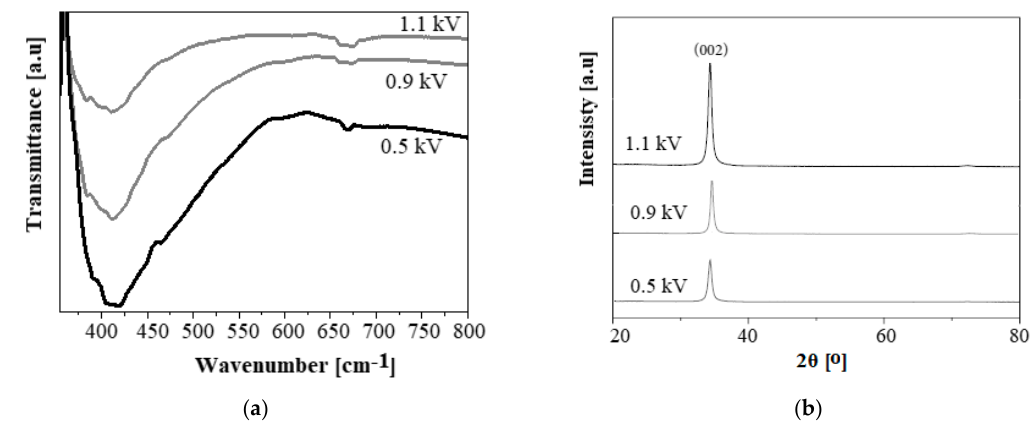
Figure 1. ( a ) FTIR spectra of ZGO films sputtered at different sputtering voltages and ( b ) XRD patterns of ZGO films sputtered at different sputtering voltages. Table 1. Description of the position and interpretation of FTIR absorption bands of ZGO films. Absorption Bands and Positions [cm –1 ] 1.1 kV